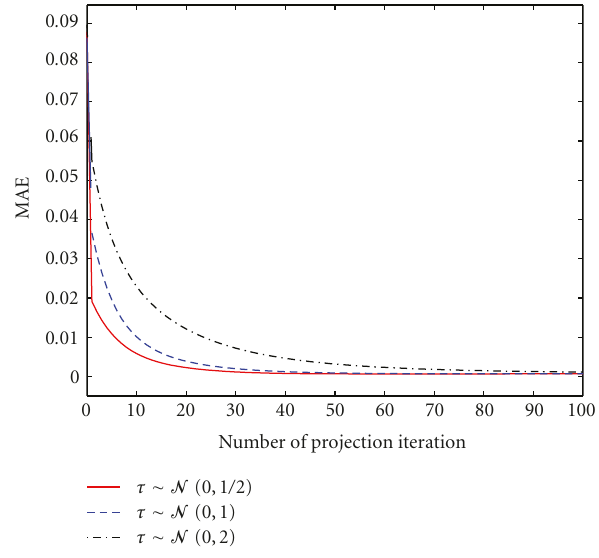
Figure 5: Convergence speed and MAE performance according to the degree of